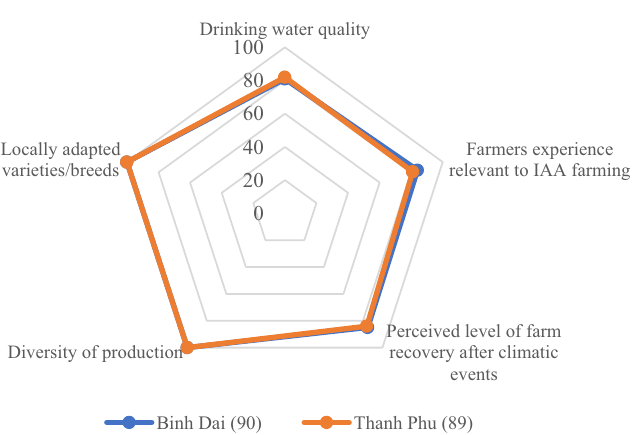
Figure 8. Compatibility theme assessment of Binh Dai and Thanh Phu communes